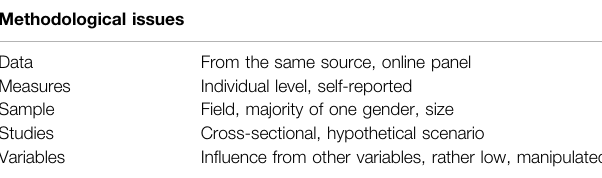
TABLE 3 | More frequent methodological